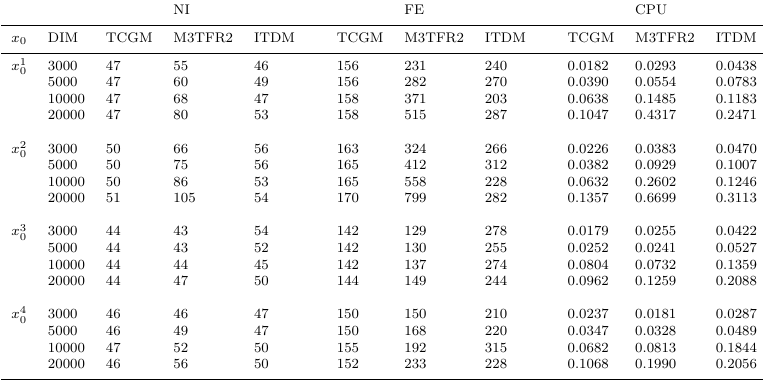
Table 10. Numerical results of Problem 10.